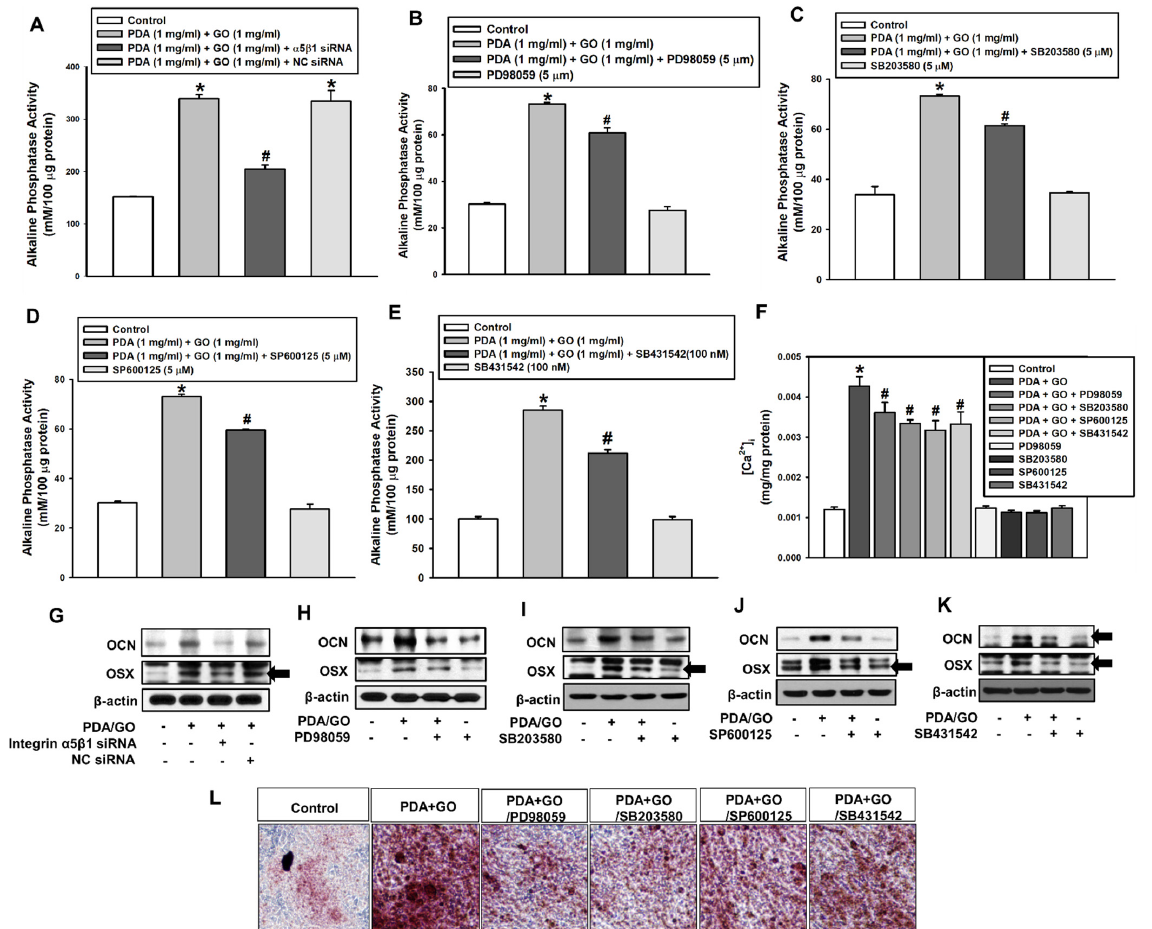
Figure 6. Role of the integrin α 5/ β 1, MAPK, and BMPR/SMAD signaling pathways in the PDA/GO-mediated osteogenic differentiation of ESCs. Cells were transfected with integrin α 5/ β 1-specific siRNA, or treated with PD98059 (5 μ M), SB203580 (5 μ M), SP600125 (5 μ M), or SB431542 (100 nM) for 48 h before ( A – E ) ALP activity, ( F ) [Ca 2+ ] i , ( G – K ) Western blot analysis, and ( L ) Alizarin Red S staining. The values are expressed as means ± SD ( n = 4). * p < 0.05 vs. each control value, and # p < 0.05 vs. PDA/GO value.